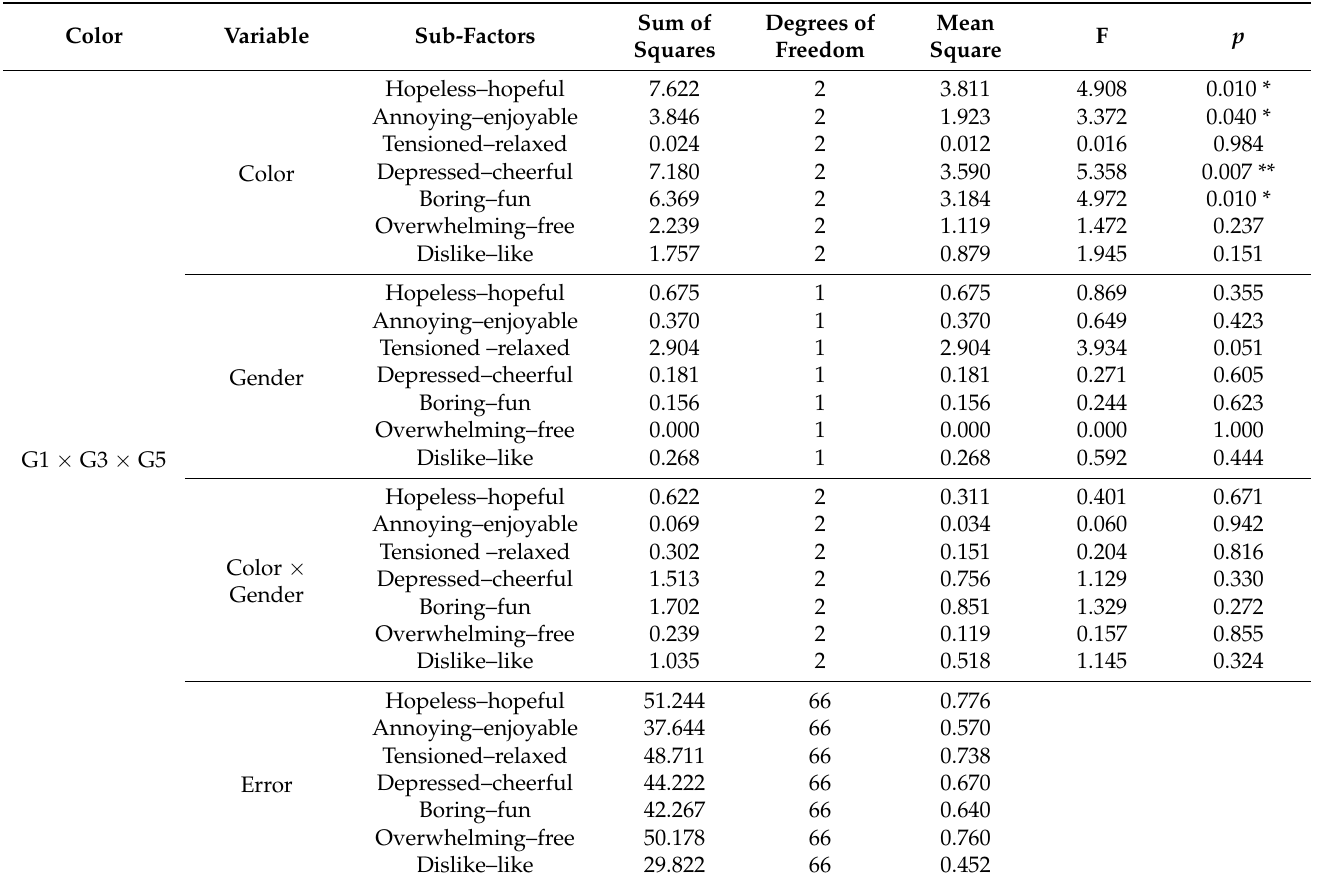
Table 10. Main and interaction effects of stress according to chroma changes under green hue and high-value